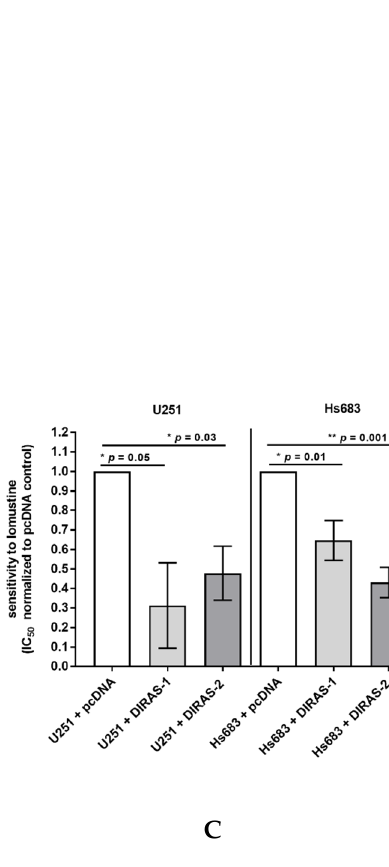
Figure 5 . Functional analyses of the role of DIRAS-1 and DIRAS-2 in human gliomas. ( A ) Western blot analysis showing DIRAS-1 and DIRAS-2 overexpression in U251MG and Hs683 cells. Detailed information about Western Blots can be found in the supplementary materials. ( B ) Cell proliferation after overexpression of DIRAS-1 or DIRAS-2 and ( C ) chemosensitivity to lomustin after overexpression of DIRAS-1 or DIRAS-2 in U251MG and Hs683 cells (n.s.: not significant, * p ≤ 0.05, ** p ≤ 0.002). Original figure in Figure